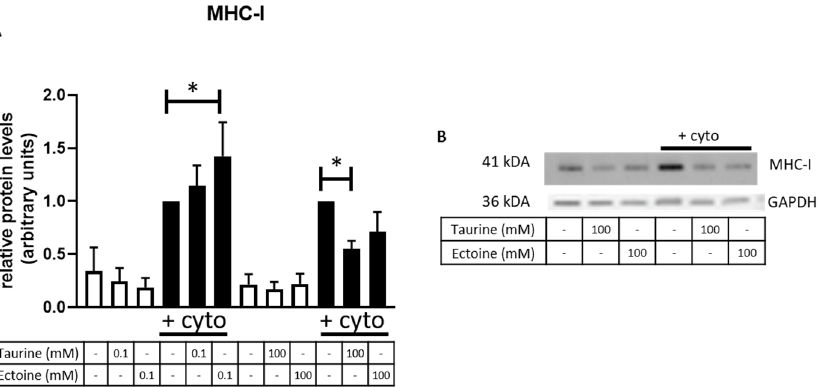
Figure 3. MHC-I protein levels in CCL-136 cells. ( A ) Relative MHC-I protein expression assessed by western blot in CCL-136 cells without treatment and 0.1 mM taurine, 100 mM taurine, 0.1 mM ectoine or 100 mM ectoine treatment prior to cytokine exposure (IL-1 β + IFN- γ ), annotated by ‘+cyto’, or without exposure to cytokines. In vitro cell experiments were conducted in quadruplicates. Data are presented as mean relative protein expression ± SEM after total protein normalization using the stain-free blot technology. Statistical analysis compared untreated and treated samples within their specific condition (no cytokine exposure/cytokine exposure), and significant differences are annotated by * ( p < 0.05). ( B ) Representative protein bands of MHC-I and GAPDH are given, as visualized with chemiluminescent and colorimetric detection, respectively, showing equal loading of lanes.